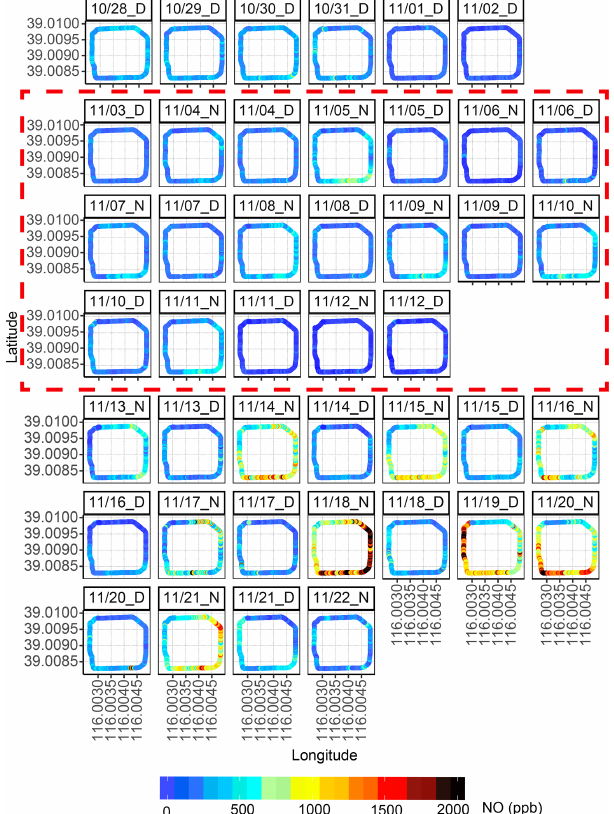
Figure 4. The spatial distributions of NO around the 4th Ring Road of Beijing from 28 October to 22 November 2014. The sub- title for each circuit indicates the observation time in the form “MM/DD_Day, Night”. The dotted red rectangle area indicates the full-APEC period.